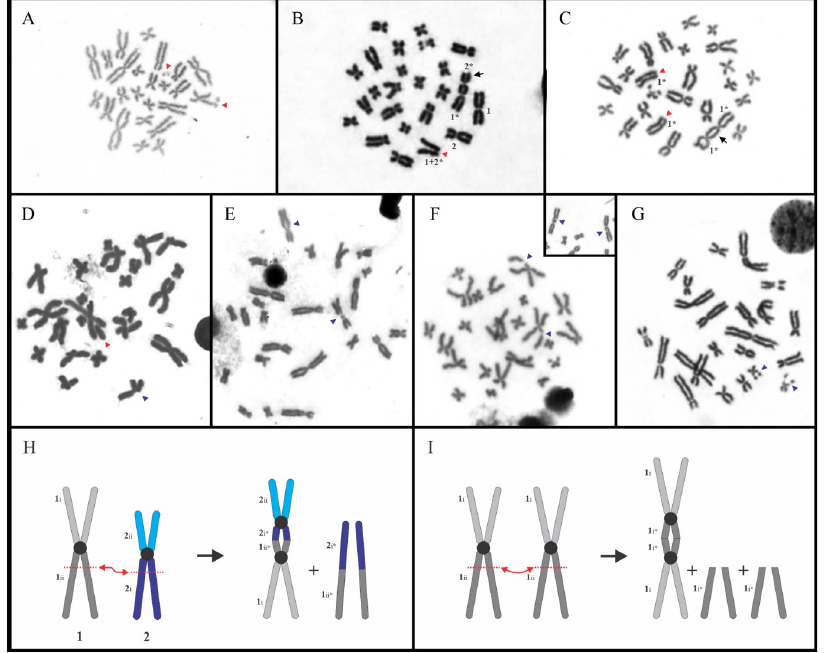
Fig 6. Spontaneous rearrangements and fragile sites in Lophyohylini. A–C, H, I. Osteocephalus taurinus . D. Nyctimantis siemersi . E. Trachycephalus typhonius . F. Osteopilus vastus . G. Dryaderces pearsoni . Red arrowheads point chromosome fragments ( A–D ), whereas blue arrowheads indicate the secondary constrictions not associated with the NOR sites ( D–G ). In ( B ) and ( C ), the black arrows show the dicentric chromosomes resulting from spontaneous rearrangements in O . taurinus , and their respective schematic representation is shown in ( H ) and ( I ). Inset: partial mitotic metaphase of Os . vastus .